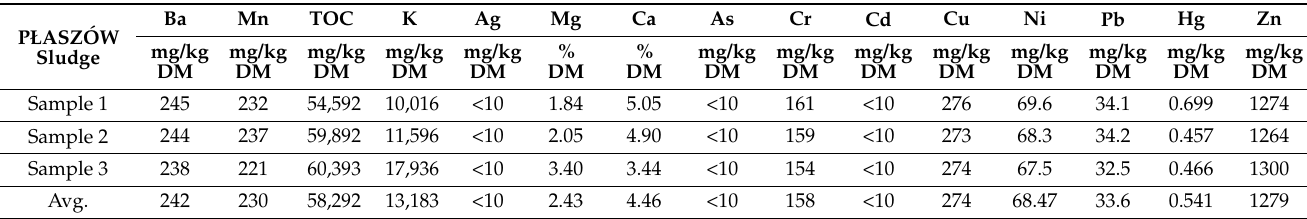
Table 2. Characteristics of digested sludge from a separate fermentation chamber at the Płasz ó w sewage treatment plant, the dry matter content in the sludge is 4.2%. (Source: Project Nr